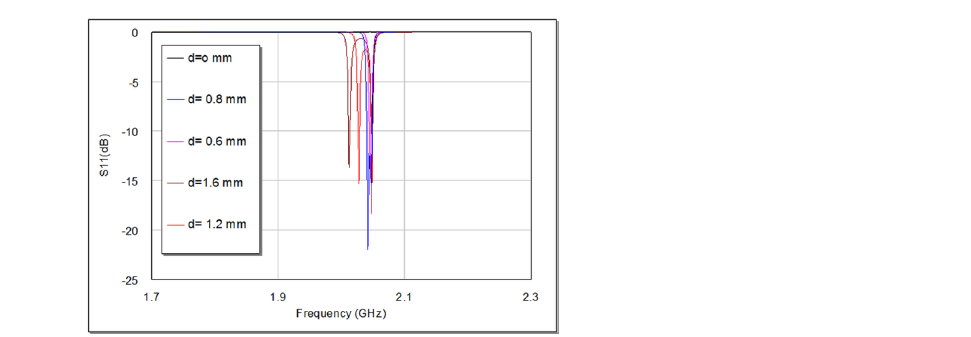
Fig 7. Simulated return loss responses, S11, of the proposed BPF as a function of d in units of mm.